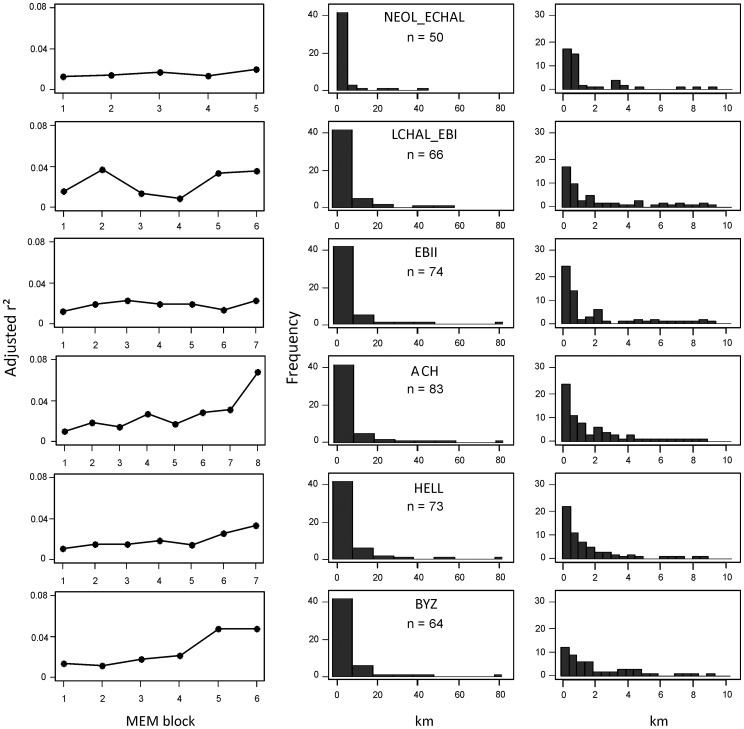
Variation in artefact abundances explained by sets of MEM variables corresponding to increasingly broader spatial scales.Left panel- Variation in artefact abundances (adjusted R2) explained by sets of MEM variables (10 variables per category) corresponding to increasingly higher spatial scales (right panel). Category one groups the ten significant MEM’s corresponding to the smallest λ, category two groups the following 10 MEM’s and so on, R2 was calculated using partial RDA models correcting for significant environmental variables and thus representing pure spatial variation [S/E]. Middle and right panel - frequency distributions of the wavelength (λ) of MEM variables retained in RDA models after forward selection illustrating variation in the scales of spatial clustering relevant during different time periods. Middle panels show all MEM’s, right panels zoom in on variation in spatial correlation within 0–10 km.